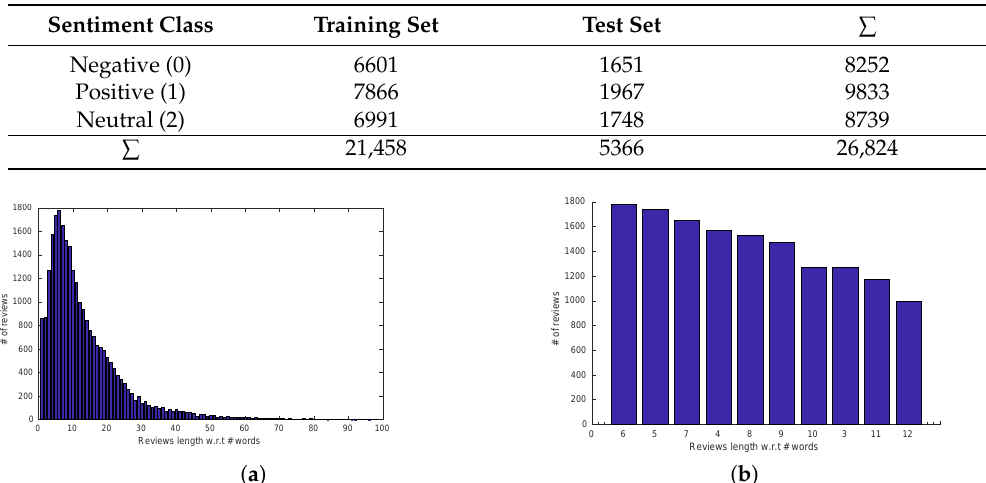
Figure 6. The distribution of reviews length: ( a ) shows the overall distribution of length from 1 to 100, and ( b ) shows the top 10 review